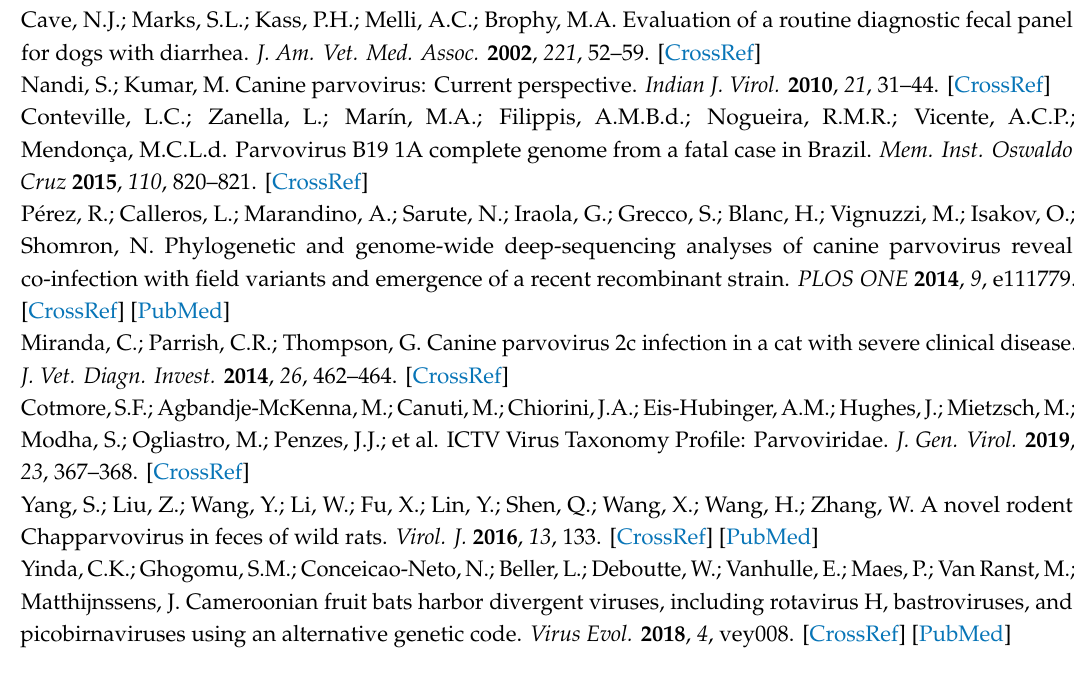
Table S1: Percent identity between NS1 proteins of